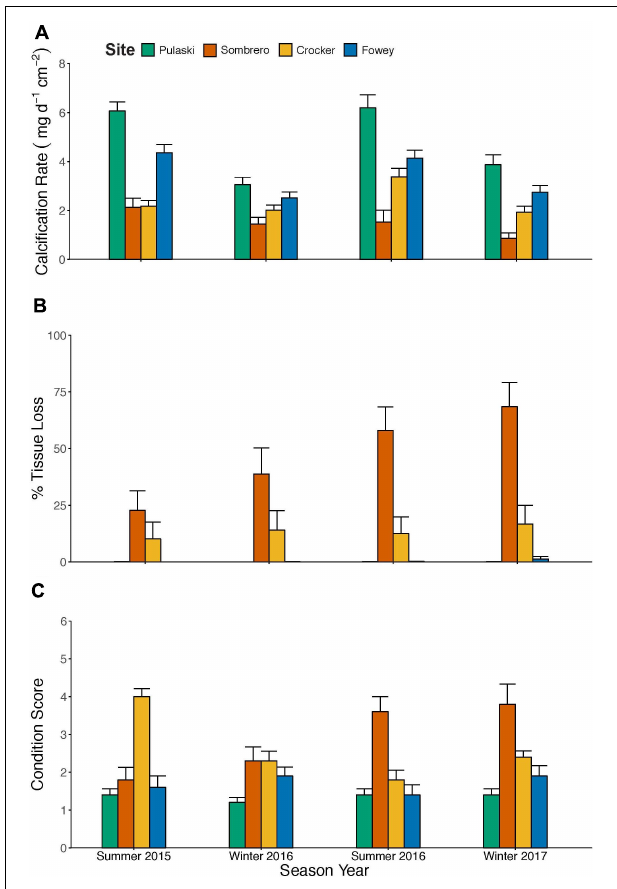
FIGURE 2 | Coral traits measured after the winter and summer seasons between April 2015 and 2017 for 40 colonies of the coral Porites astreoides from four sites on the Florida Keys Reef Tract. (A) Mean net calcification rates normalized to planar-footprint area ( ± SE), (B) accumulative percent-planar tissue loss ( ± SE), and (C) condition scores at the end of each 6-month time period based on a scale from 1 to 6, with six indicating the poorest condition based upon paling, bleaching, and mortality (Baird et al.,